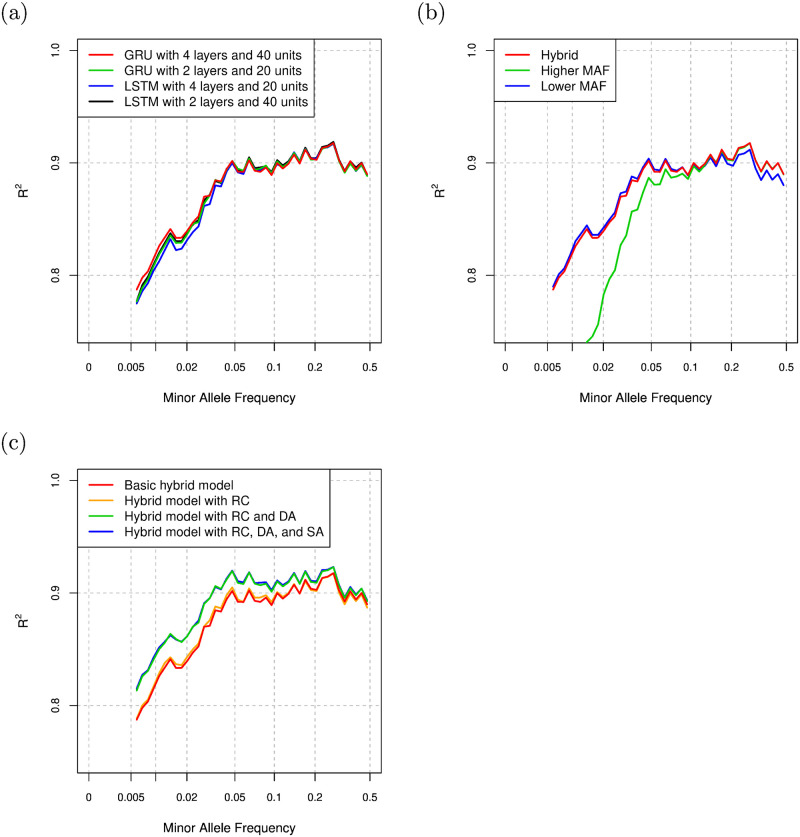
(a) Comparison of R2 values for the proposed method with several settings. (b) Comparison of R2 values for the proposed method with hybrid model, higher MAF model, and lower MAF model with the setting of GRU, 4 layers, and 40 hidden units. (c) Comparison of R2 values for the proposed method with and without residual connection (RC), data augmentation (DA), and self-attention (SA), where “Basic hybrid model” is the hybrid model without RC, DA, and SA.